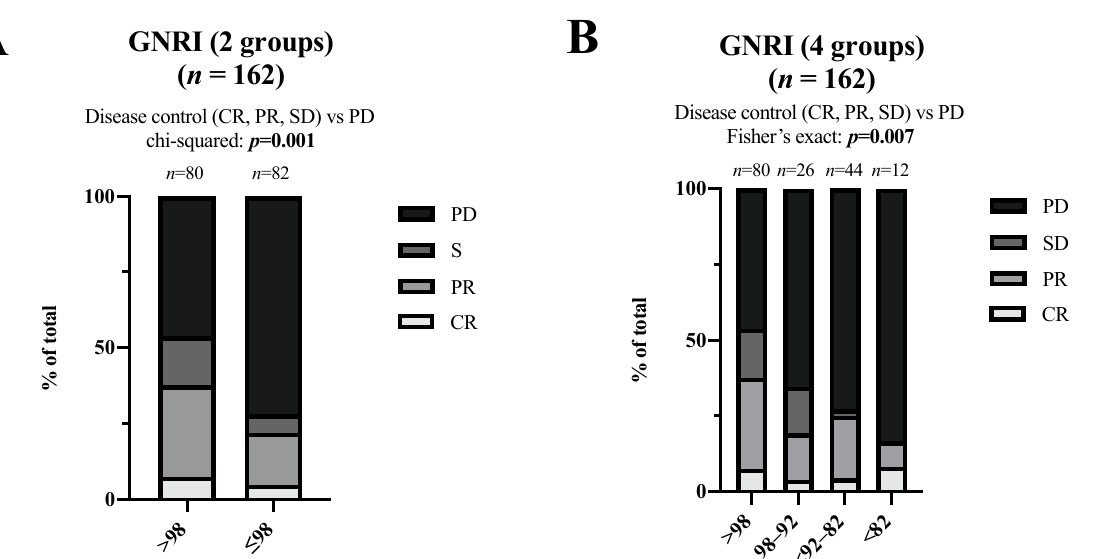
Figure 2. bOR of dichotomized GNRI ( A ) and original GNRI ( B ) groups. The difference in DCR (CR, PR, or SD) between groups was compared using chi-squared or Fisher’s exact test. Significant results ( p ≤ 0.05) are highlighted in bold print. GNRI, Geriatric Nutritional Risk Index; DCR, disease control rate; CR, complete response; PR, partial response; PD, progressive disease; SD, stable disease.